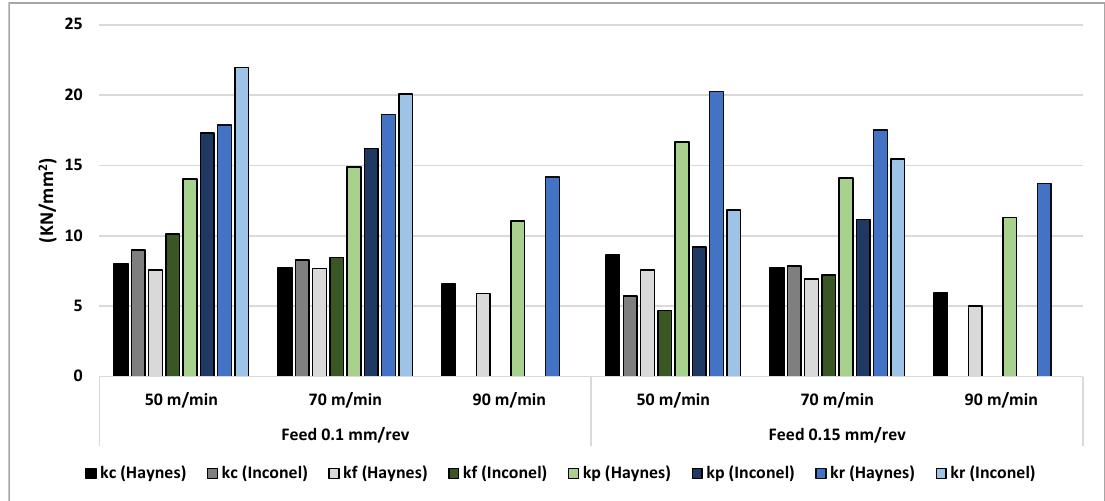
Figure 6. Specific cutting forces for both Haynes [36] and Inconel [38] under conventional pressure with worn tool.